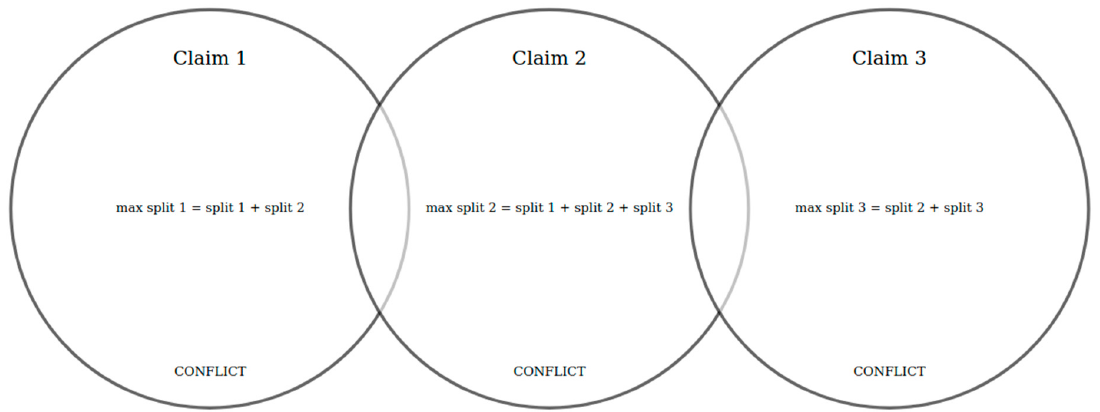
Figure 9. Explanation of a claim’s max split field in a Venn diagram. All max splits here are greater than 100.